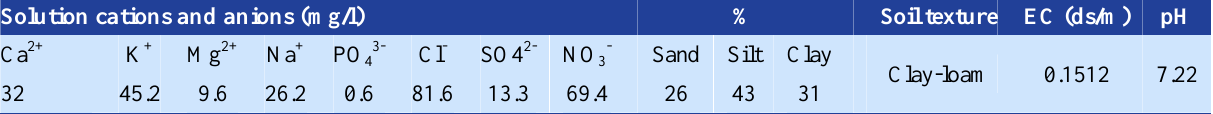
Table 2. Some physical and chemical properties of the studied soils Solution cations and anions (mg/l)